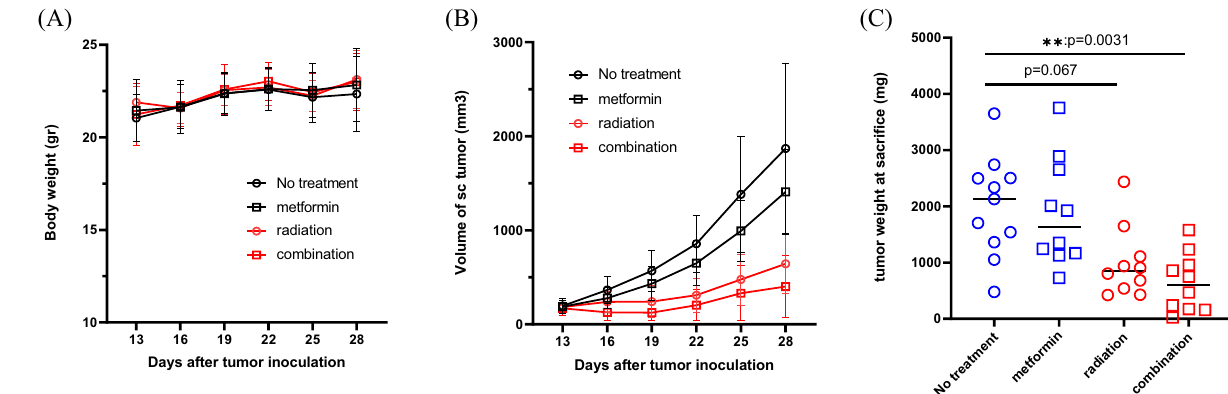
Figure 2. Mouse body weight ( A ) and tumor volume ( B ) were measured once every 3 days after the initiation of treatment. Mice were sacrificed on day 28 and the weight of subcutaneous tumors measured ( C ). The combined data of the results of 2 experiments (n = 5 in each) are shown: ** p < 0.01.